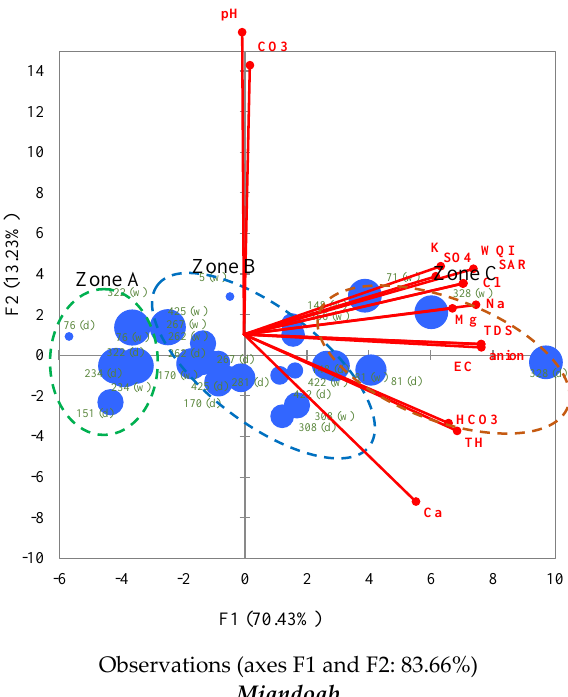
Observations (axes F1 and F2: 83.66%) Figure 9. PCA analysis of 356 wells in 9 aquifers and 2 dry (d) and rainy (w) seasons during the 20-year study period with 14 quality variables combined with cluster analysis results (Zone A to E).